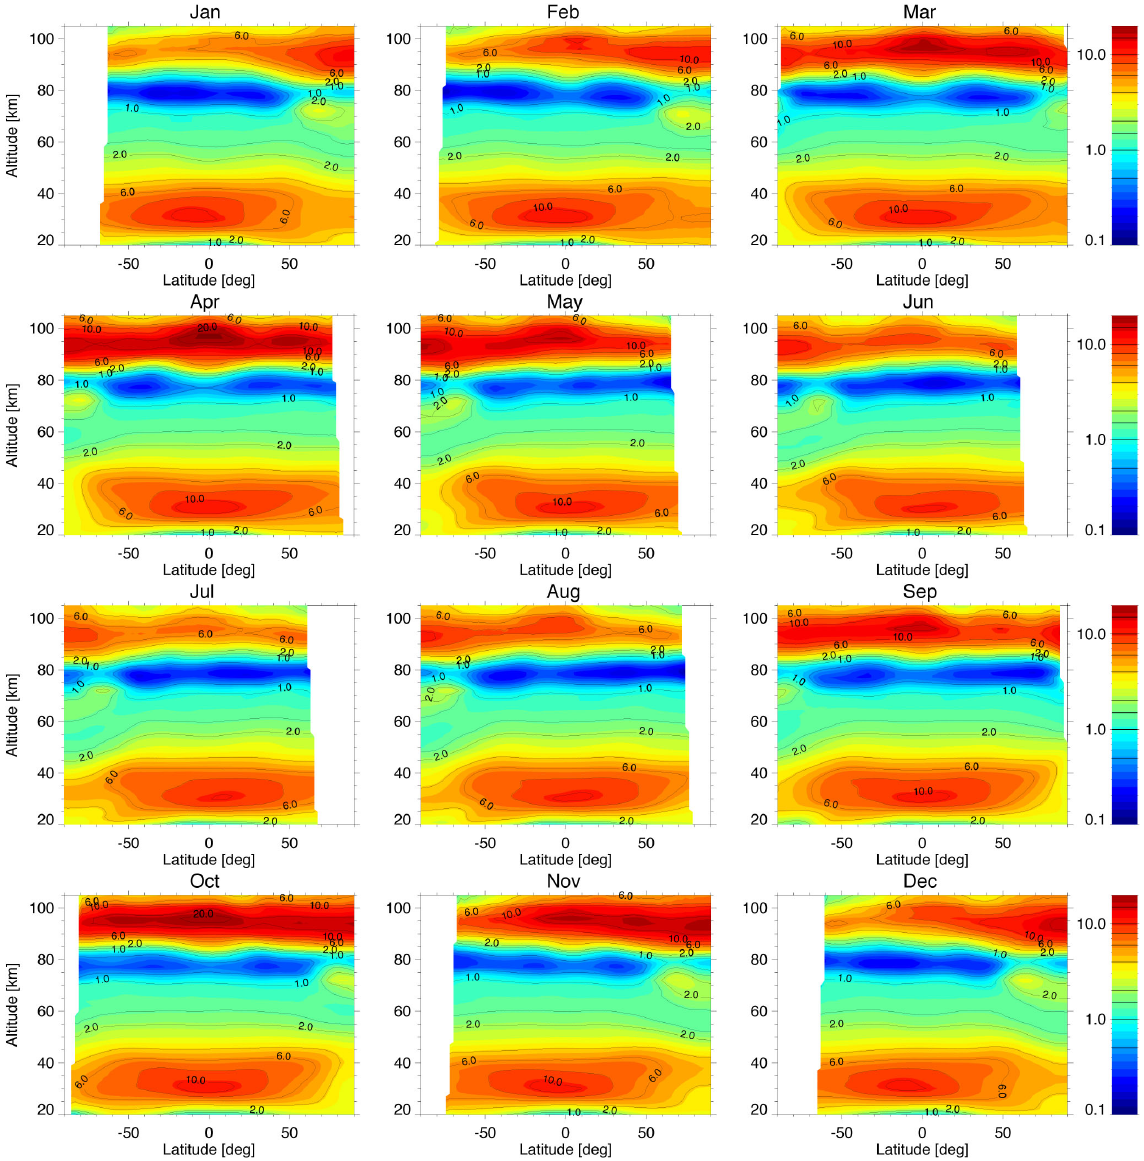
Figure 12. Composite monthly zonal mean of MIPAS data for the 2017–2012 period for nighttime. Contours are 0.5, 1, 1.5, 2, 4, 6, 8, 10, 15, and